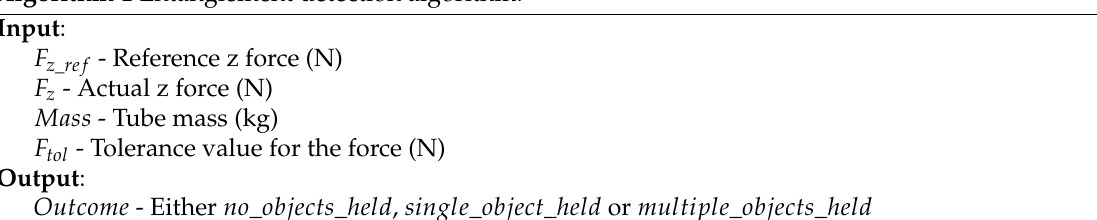
Algorithm 1 Entanglement detection